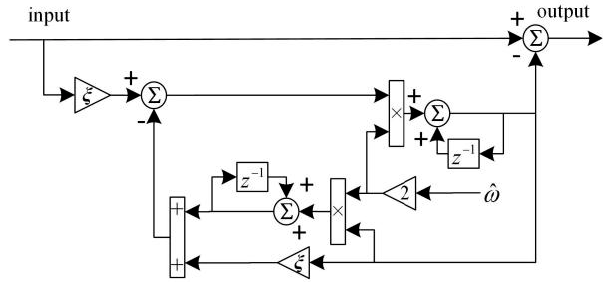
Figure 18. Discrete-time realization of ANF. Table 3. Calculation operators in filtering stage.